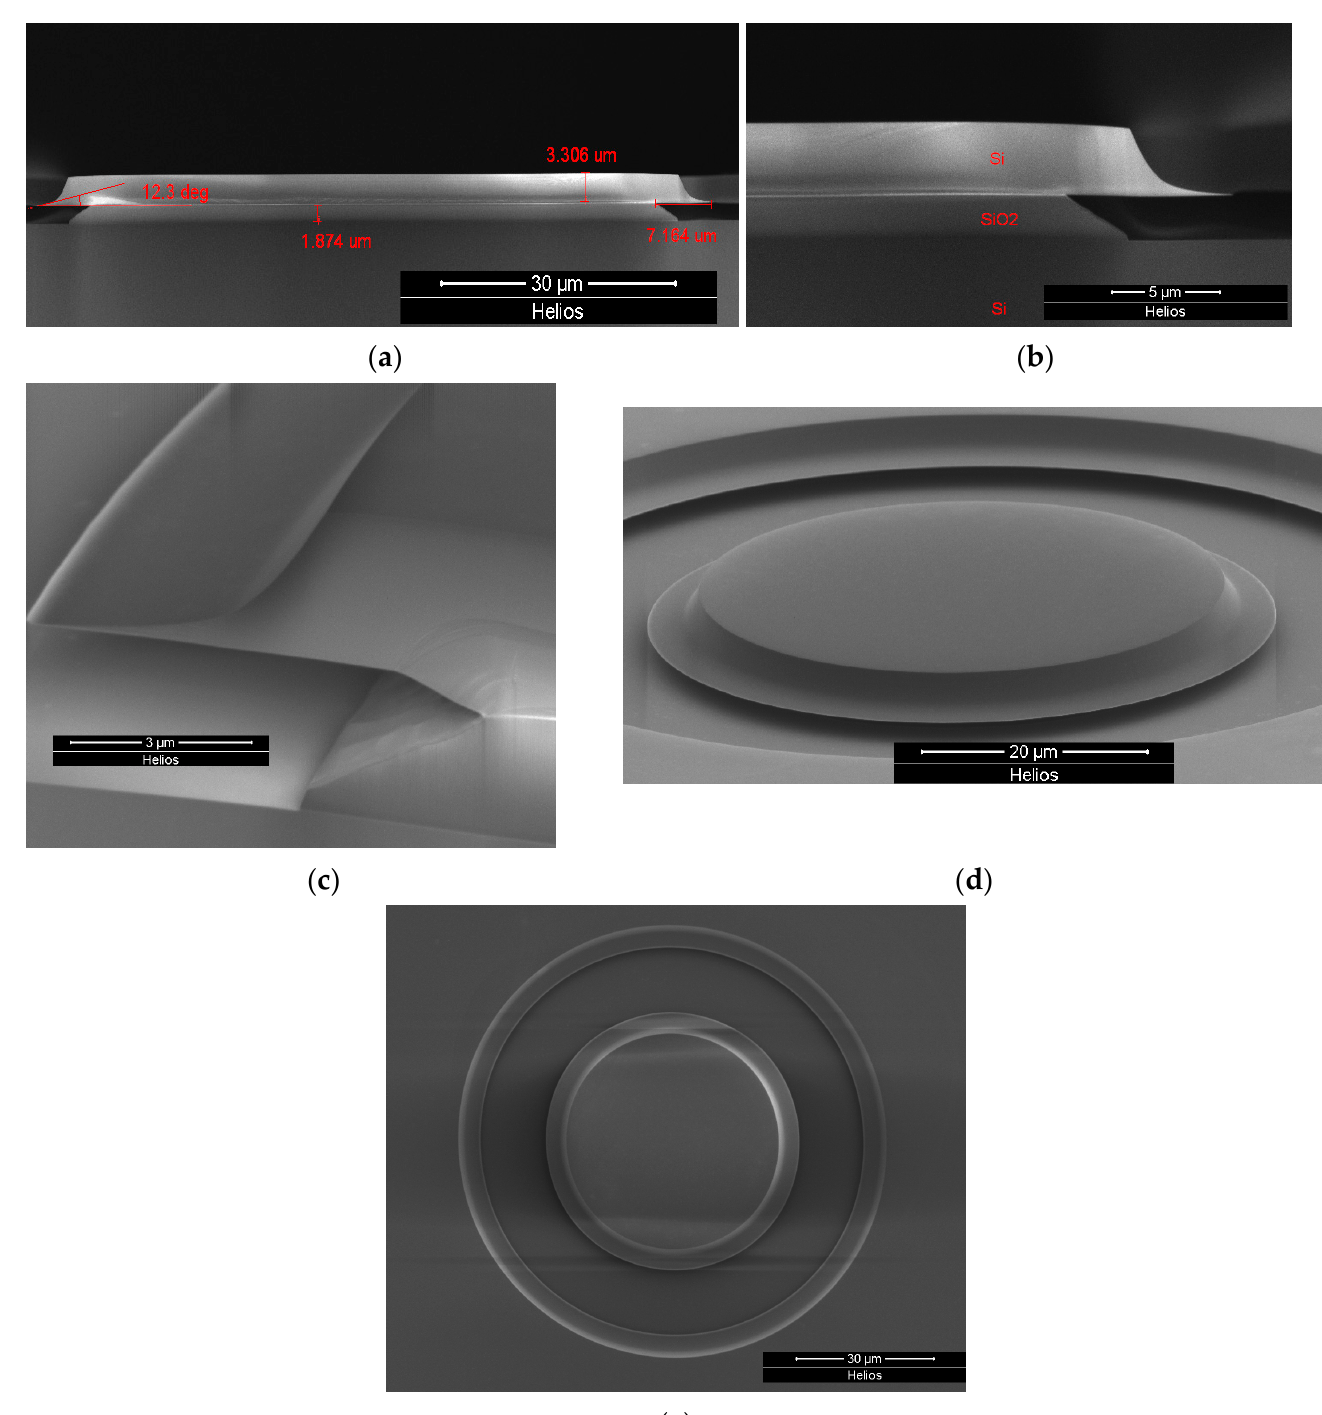
Figure 2. SEM images of silicon disk WGM resonators with a wedge-shaped profile: ( a ) cross-section of the structure of the silicon WGM resonator; ( b ) enlarged image of the wedge-shaped profile; ( c ) enlarged image of the surface of the formed silicon structure; ( d ) appearance; ( e ) top view.